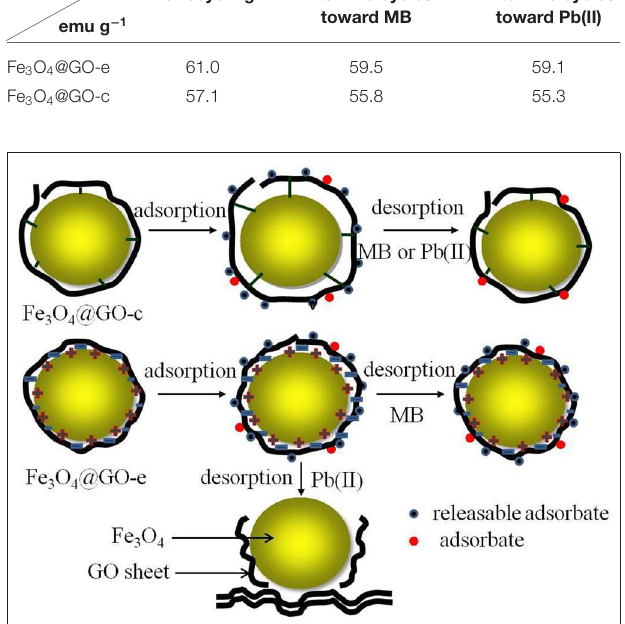
TABLE 1 | The maximum saturation magnetisms of the Fe 3 O 4 @GO samples before and after five cycles of adsorption-desorption toward MB and Pb(II). Samples